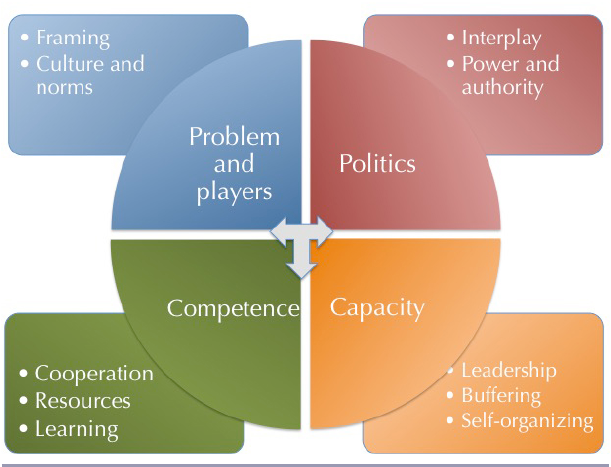
Fig. 1 . Diagram of conceptual framework used in this